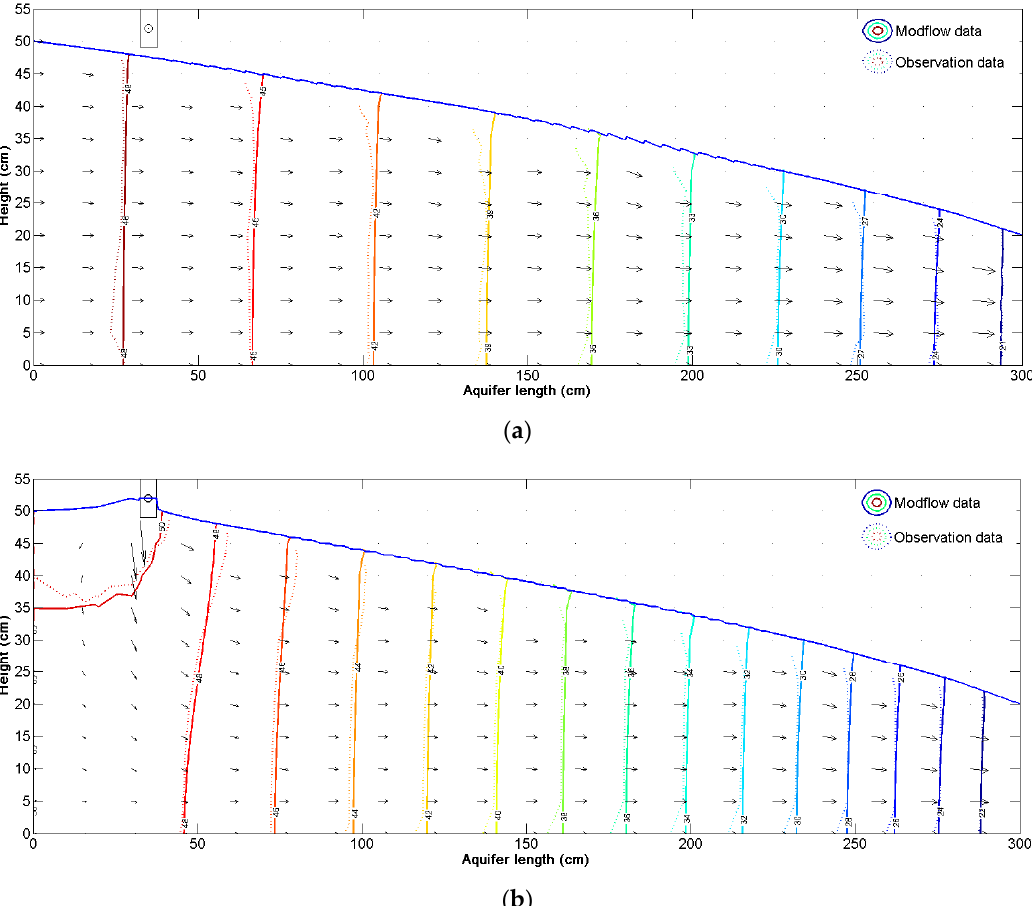
Figure 4. Simulated groundwater flow (solid line) of the sand tank model by MODFLOW and actual groundwater flow (dotted line) interpolated by data from pressure sensors. ( a ) Self-filtration stage. ( b ) Clean water infiltration stage. The arrow size indicates the velocity of the water flow.